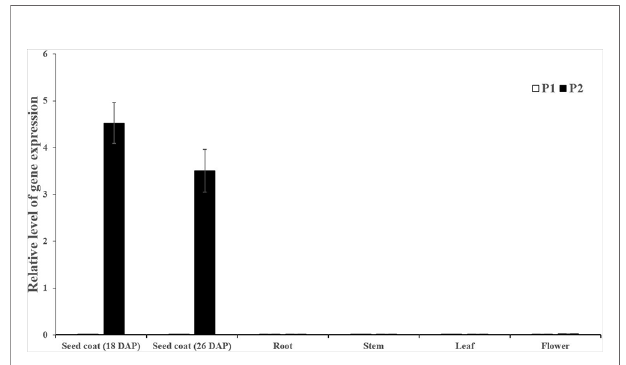
FIGURE 3 | Quantitative real-time PCR analysis of Cla019481 in different development stages (18 and 26 DAP) and different tissues. Three biological and technical replicates were used